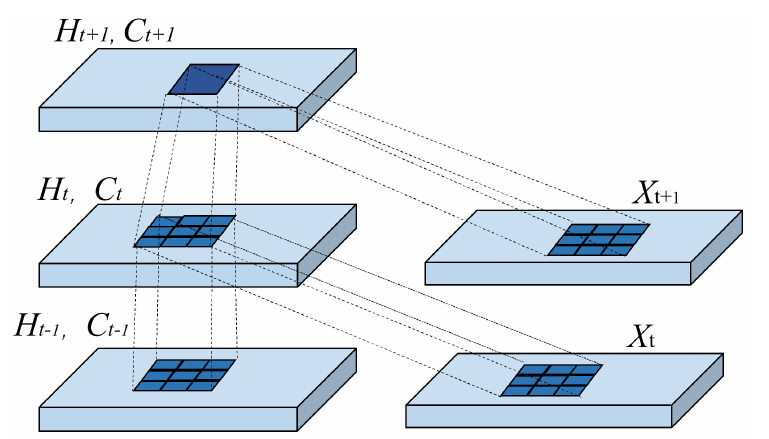
Figure 3. Inner structure of ConvLSTM